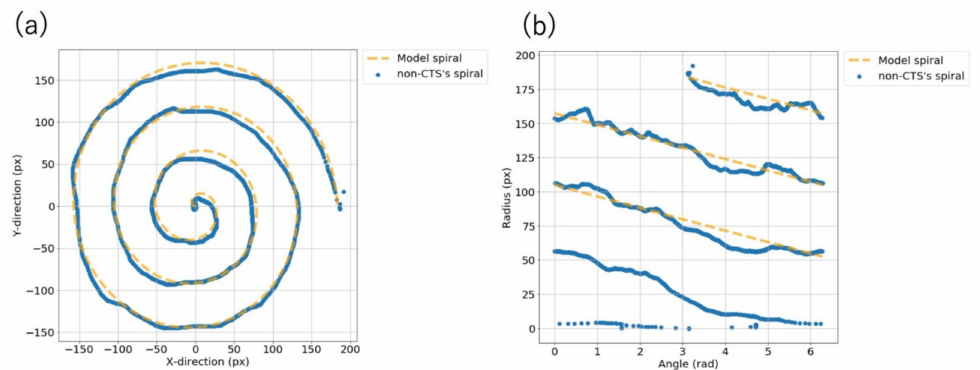
Figure 4. ( a ) Spiral plotted in the Cartesian coordinate system. ( b ) Spiral plotted with θ on the horizontal axis and r on the vertical axis. The solid line is the spiral drawn by a non-CTS participant, and the dashed line is the model spiral. We calculated the root mean square error between the solid and dashed